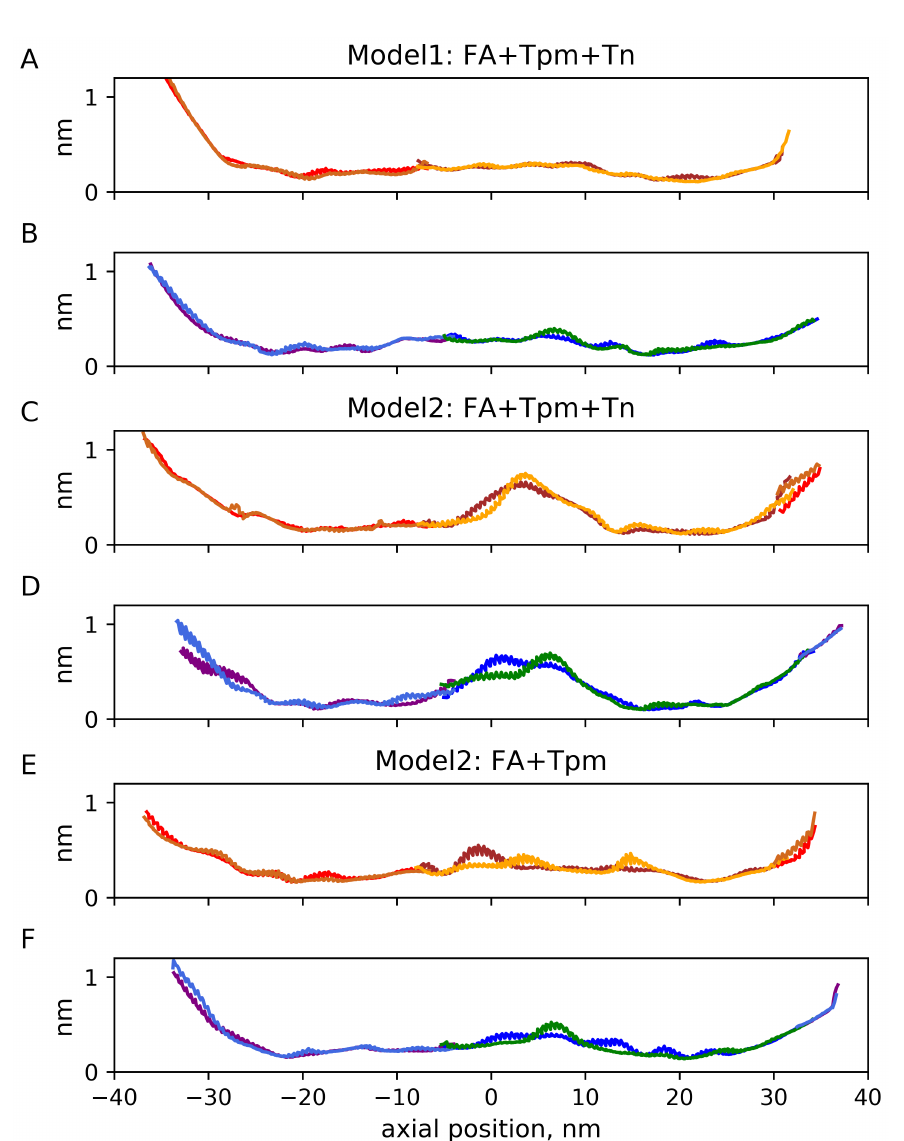
Figure 4. Time-averaged radial fluctuations of Tpm strands 1 (red/light brown and brown/orange; ( A , C , and E ) panels) and 2 (purple/light blue and blue/green; ( B , D , and F ) panels). The same color code as in Figure